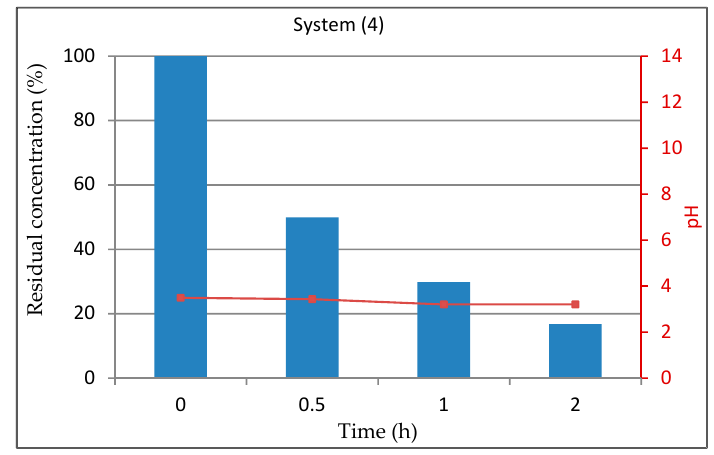
Figure 10. Residual concentration (%) and pH for System 4, as a function of the UV irradiation time exposure.